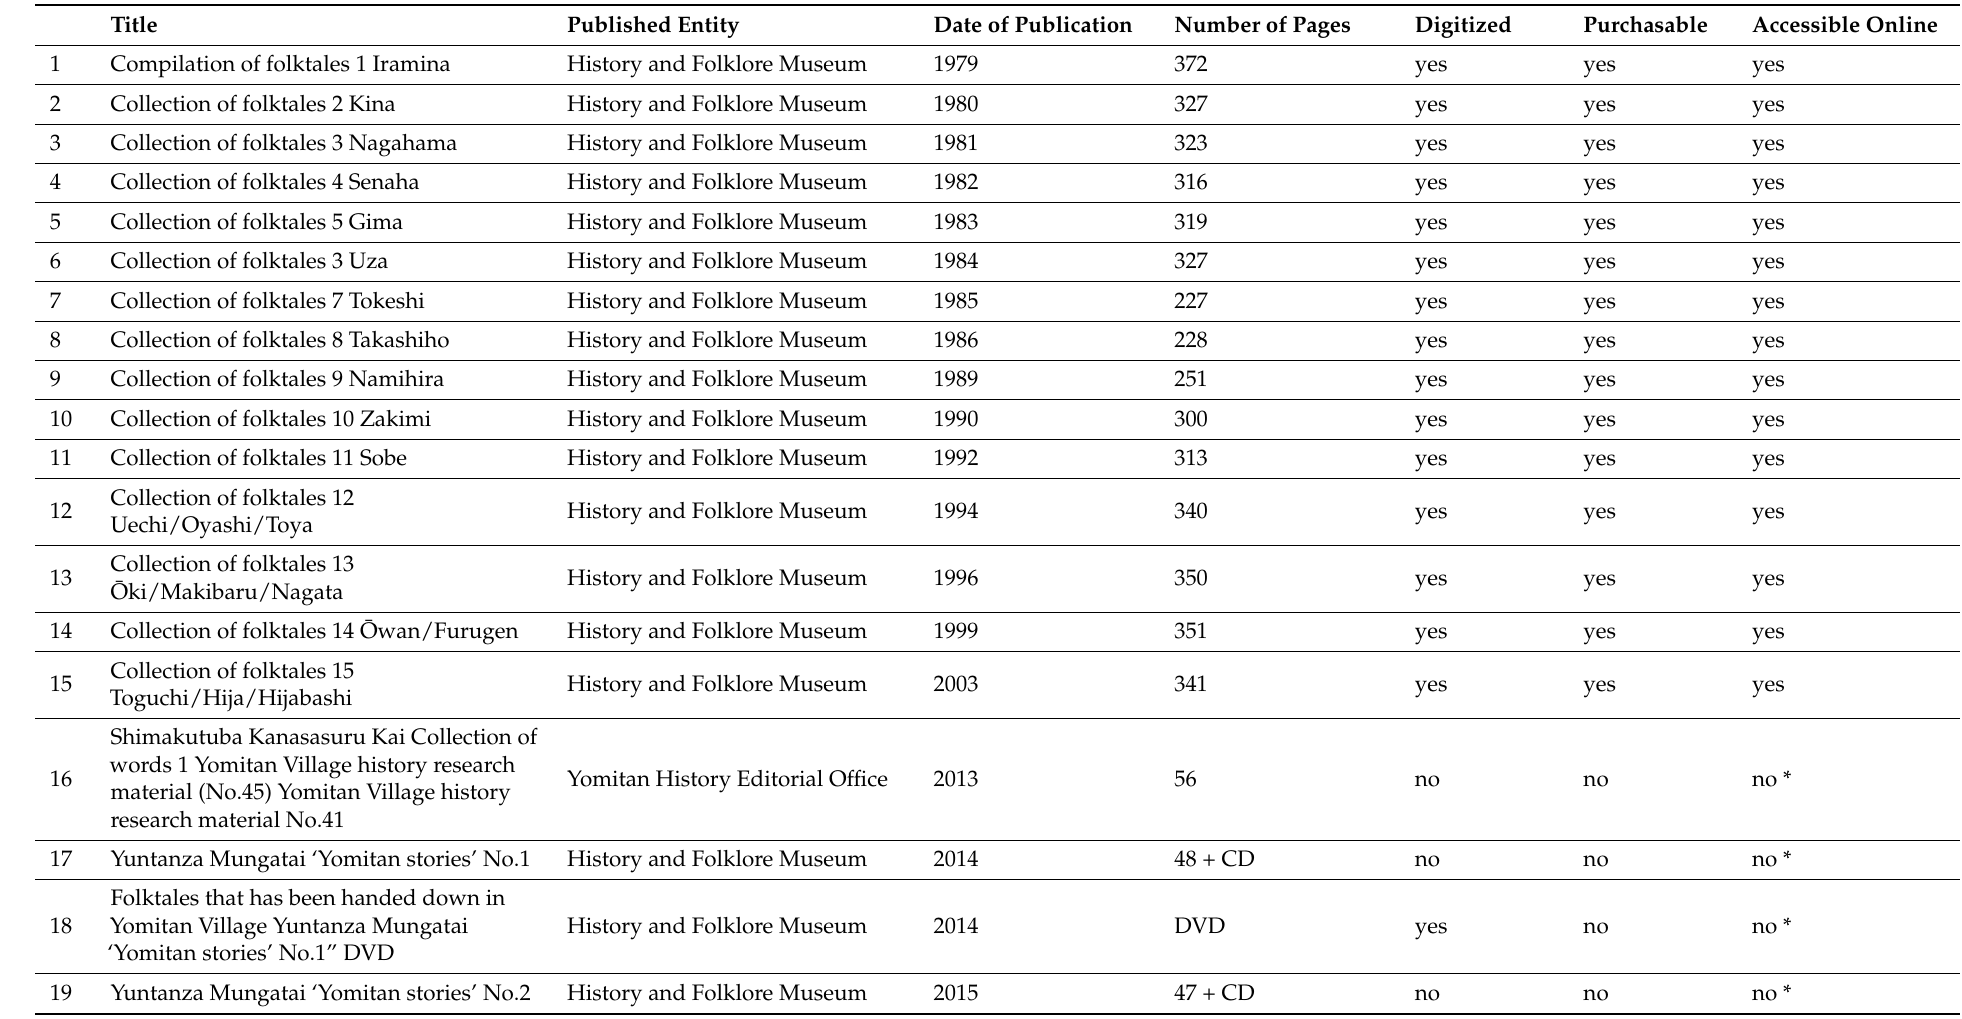
Table 1. List of books related to shimakutuba by Yomitan